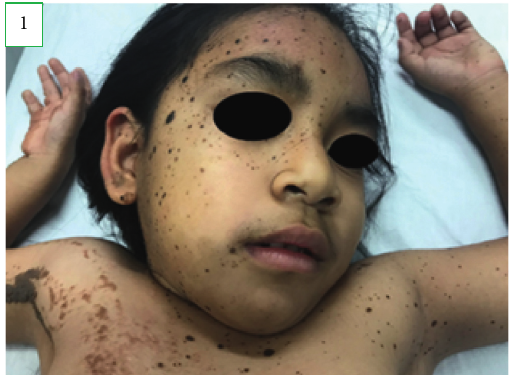
Figure 1: Skin patterns of the melanocytic and verrucous nevi on the face and the upper trunk